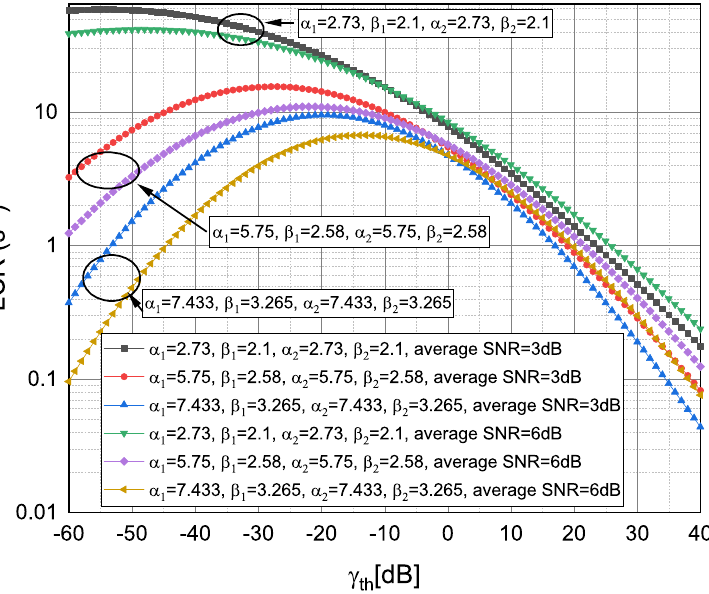
Figure 6. Average level crossing rate versus γ th observed for different TI fading severity conditions and different ¯ γ th